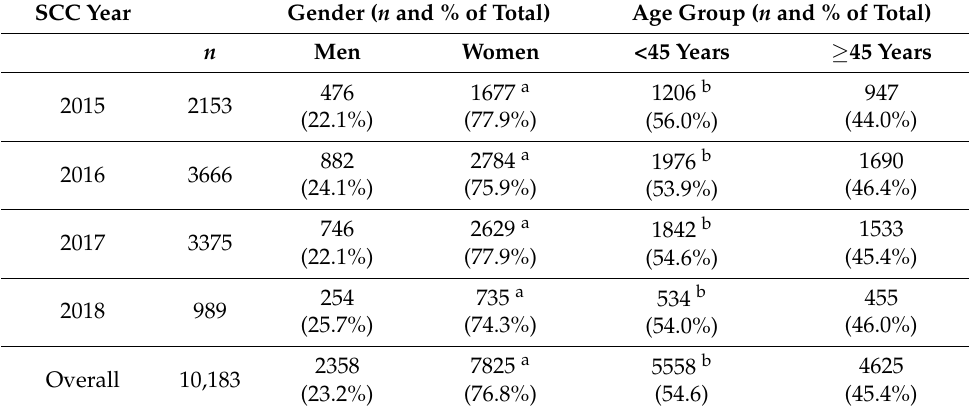
Table 1. Participant breakdown by Step Count Challenge year, gender, and